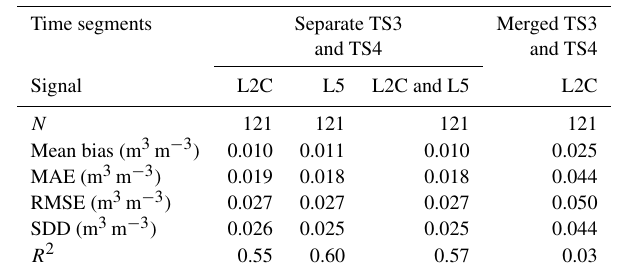
Table 4. Soil moisture scores between daily mean in situ VSM ob- servations at a depth of 5cm and GNSS VSM retrievals (either L2C or L5 or both) during TS3 and TS4 (SNR data from the 3.3m an- tenna with 1s sampling interval from 8 June to 6 October 2016). The Zhang et al. (2017) method is used for separated time segments, and also for merged time segments. MAE, RMSE, SDD and N are defined in Table